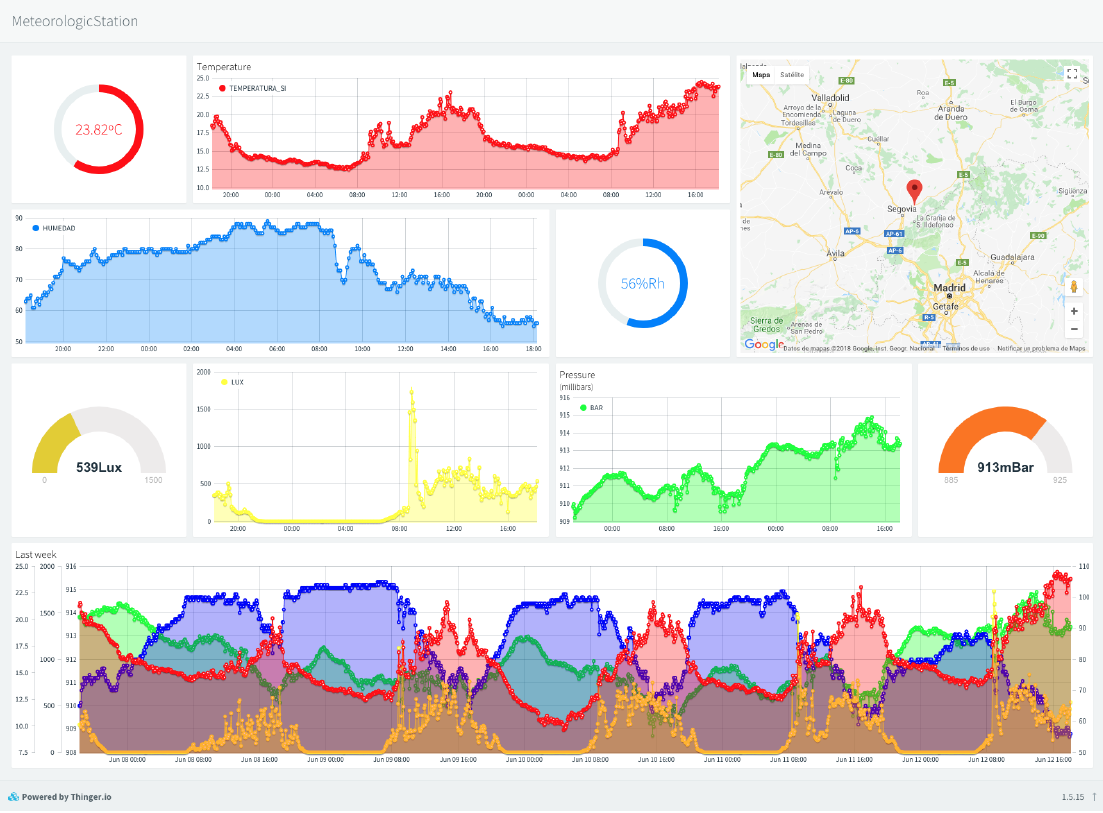
Figure 22. An example of the console of